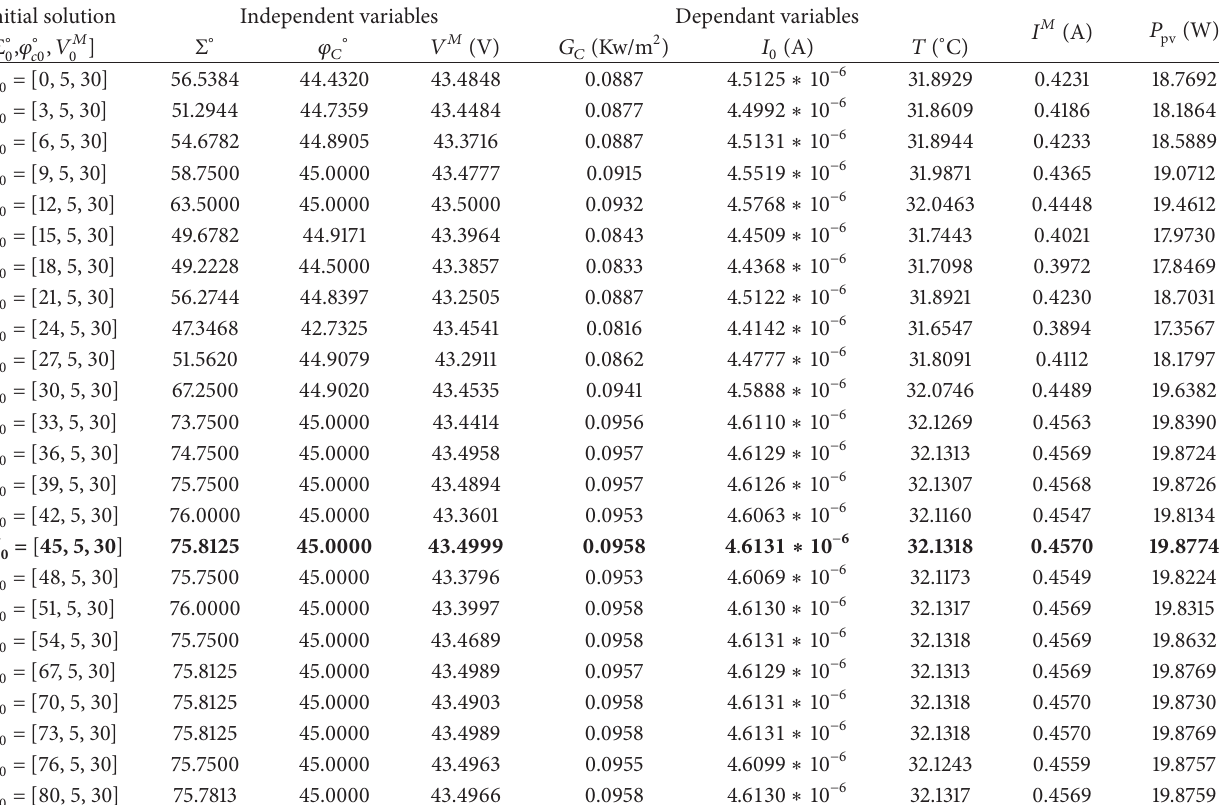
Table 2: Effect of changing the initial tilt angle on the module power at 6:10